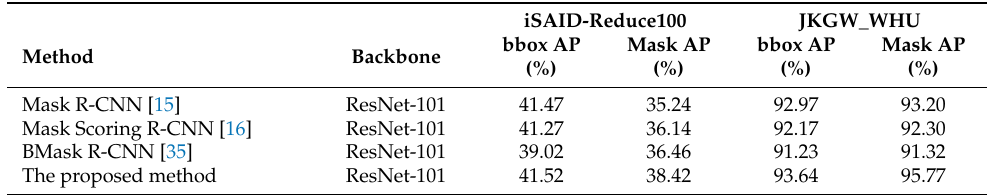
Table 3. Quantitative comparison of Mask R-CNN, Mask Scoring R-CNN, BMask R-CNN and the proposed method on the iSAID-Reduce100 val set and the JKGW_WHU test set.